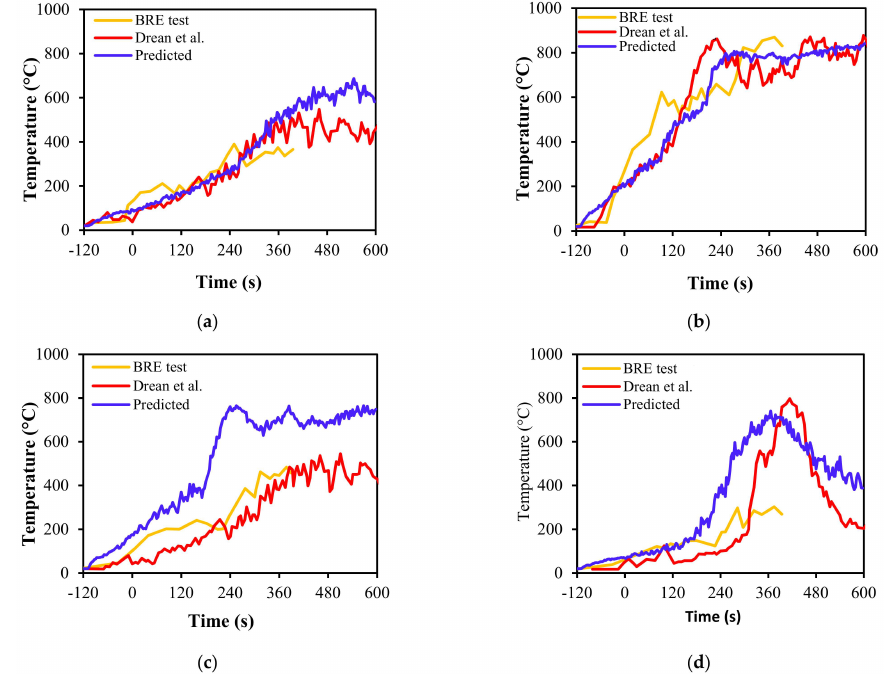
Figure 6. Comparison of test and predicted temperatures of centrally positioned thermocouples at